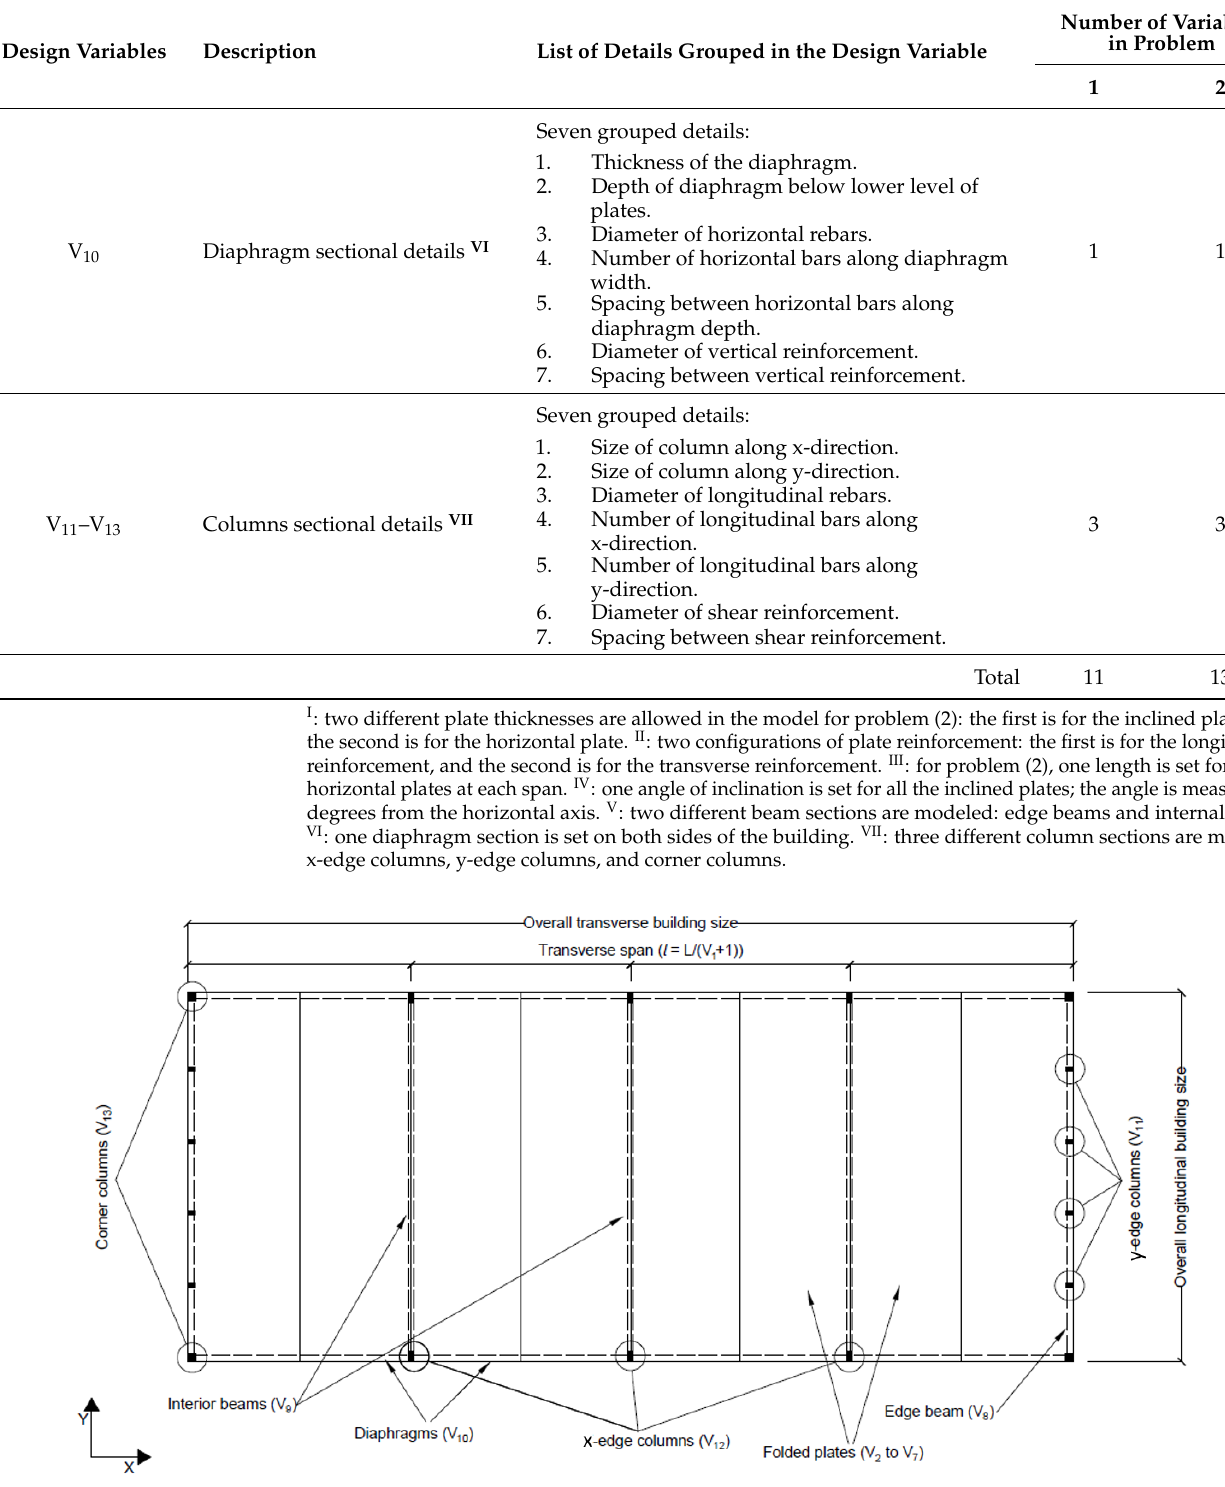
Figure 1. Typical folded plate building roof plan.